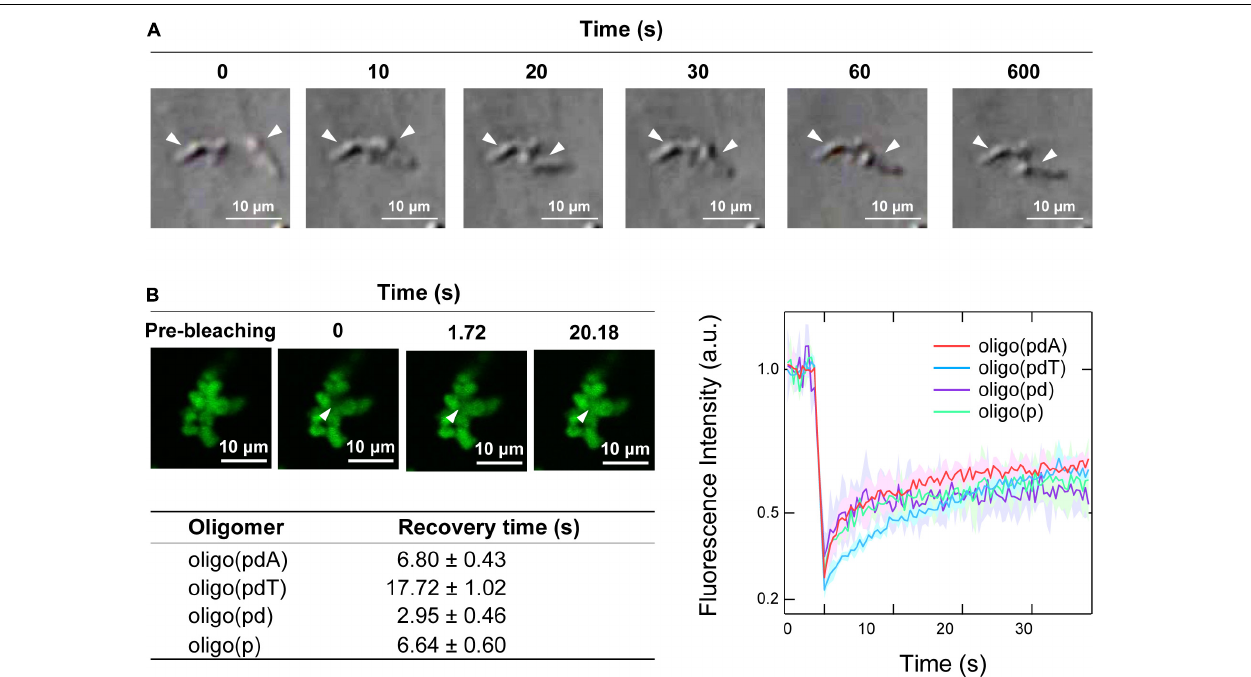
FIGURE 4 | Physical properties of the non-spherical assemblies. (A) Collision process of the non-spherical assemblies formed by oligo(pdA) (5.0 µ M) and H1 (7.5 µ M); scale bar = 10 µ m. (B) Left: confocal fluorescence microscopy images during the FRAP measurements. White arrowheads indicate the bleached areas; scale bar = 10 µ m. Right: FRAP recovery curves for the oligomers; values shown represent mean values ± standard deviation ( n = 3). The table below lists the fluorescence-recovery times calculated by single-exponential fitting.